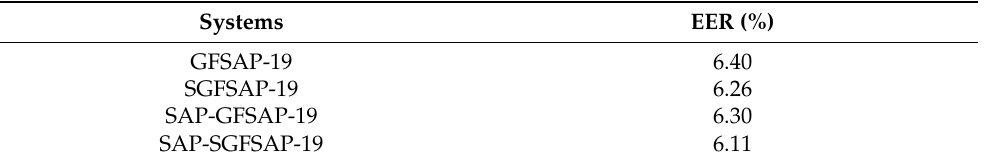
Table 5. Effectiveness of